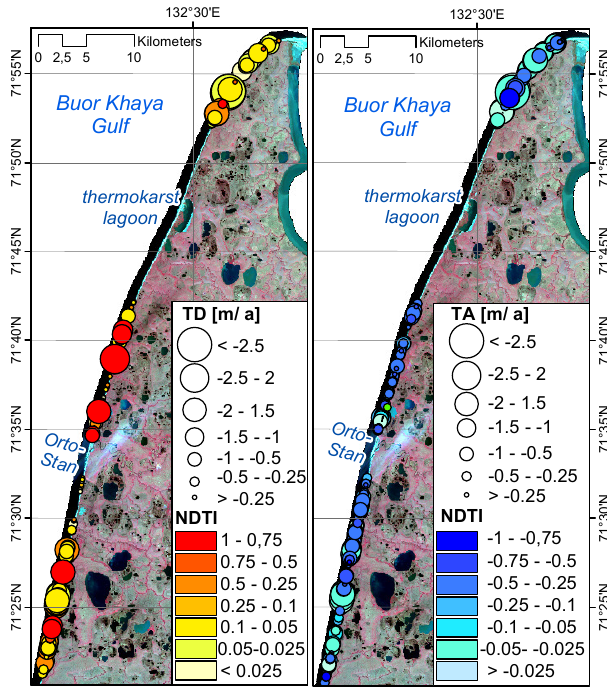
Fig. 8. Thematic map of coastal thermo-erosion transect data along the studied coastline of Buor Khaya (west coast of the Buor Khaya Peninsula). The upper map segment illustrates colour coded positive NDTI values associated with prevailing thermo-denudation (TD), the lower map illustrates colour coded negative NDTI values as- sociated with prevailing thermo-abrasion (TA). The symbol size is equivalent to erosion